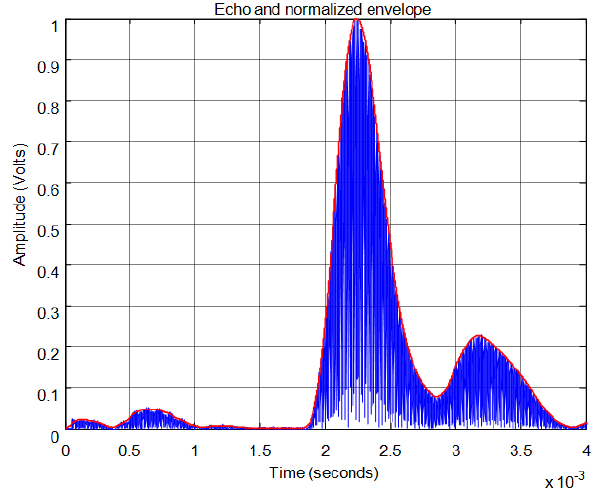
Figure 21. Normalized echo and envelope for an echo formed by two overlapping sub-echoes.